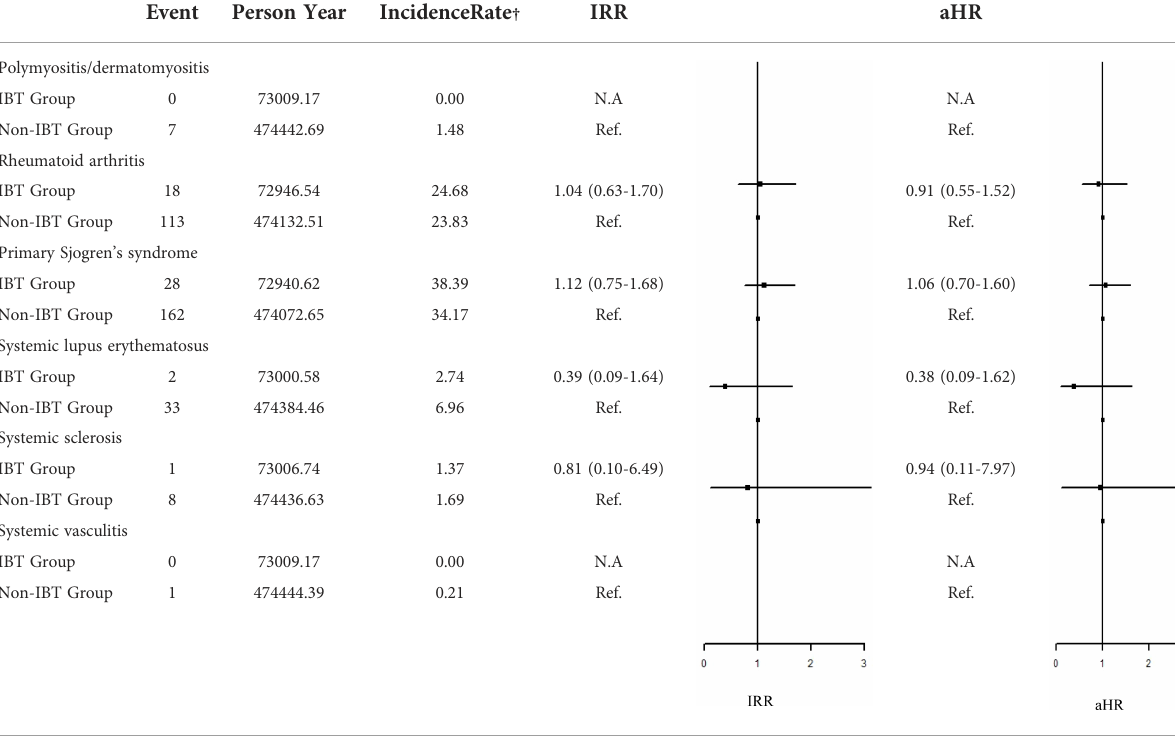
TABLE 4 Incidence Rate Ratio and Hazard Ratio of the Risk of systemic ADs between IBT and non-IBT group.